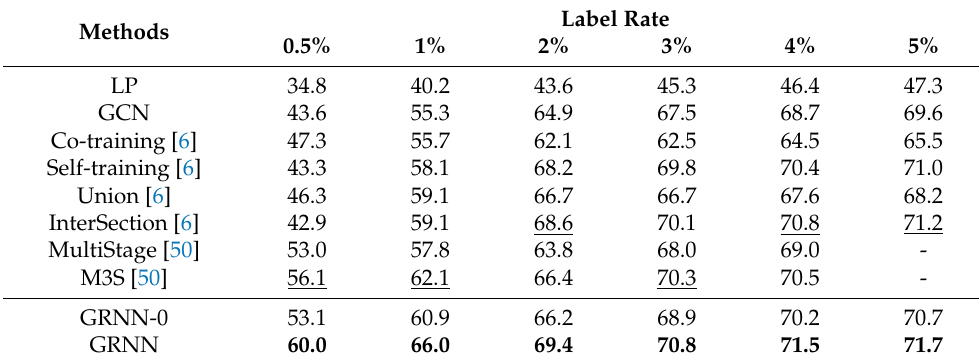
Table 5. Summary of classification accuracy (%) results with fewer training samples on Citeseer.